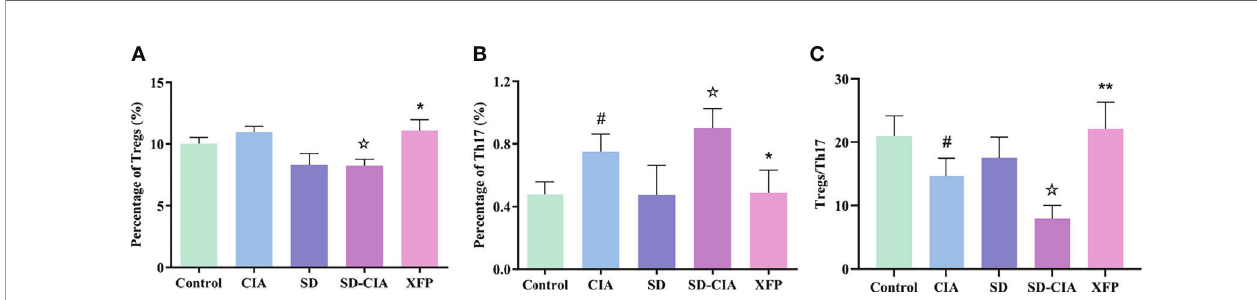
FIGURE 4 | The modulatory effect of XFP on the immune status of the PPs. The percentages of Tregs and Th17 cells and the Tregs/Th17 ratio in PPs were detected by fl ow cytometry. (A) Bar charts showing the percentage of Tregs by fl ow cytometry. (B) Bar charts showing the percentage of Th17 cells by fl ow cytometry. (C) The ratio of Tregs/Th17 cells in each group. n = 8. Data are presented as the mean ± SEM . # P < 0.05 compared to the control group; ☆ P < 0.05 compared to the CIA group; *P < 0.05 and **P < 0.01 compared to the SD-CIA group. XFP, Xiong Fu powder; CIA, collagen-induced arthritis; SD, spleen de fi ciency; SD-CIA, collagen-induced arthritis with spleen de fi ciency; PPs, Peyer ’ s patches; Tregs, T regulatory cells; Th17, T helper 17.